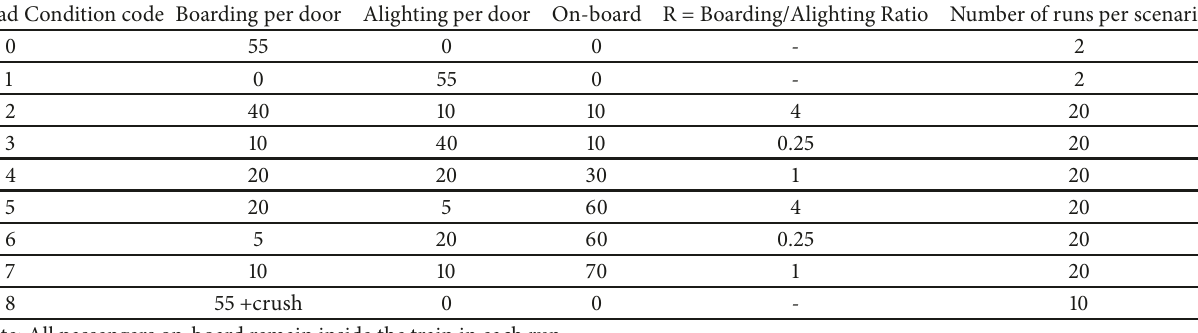
Figure 2: Different views of the simulated experiments at PAMELA. Table 1: Load condition descriptions at